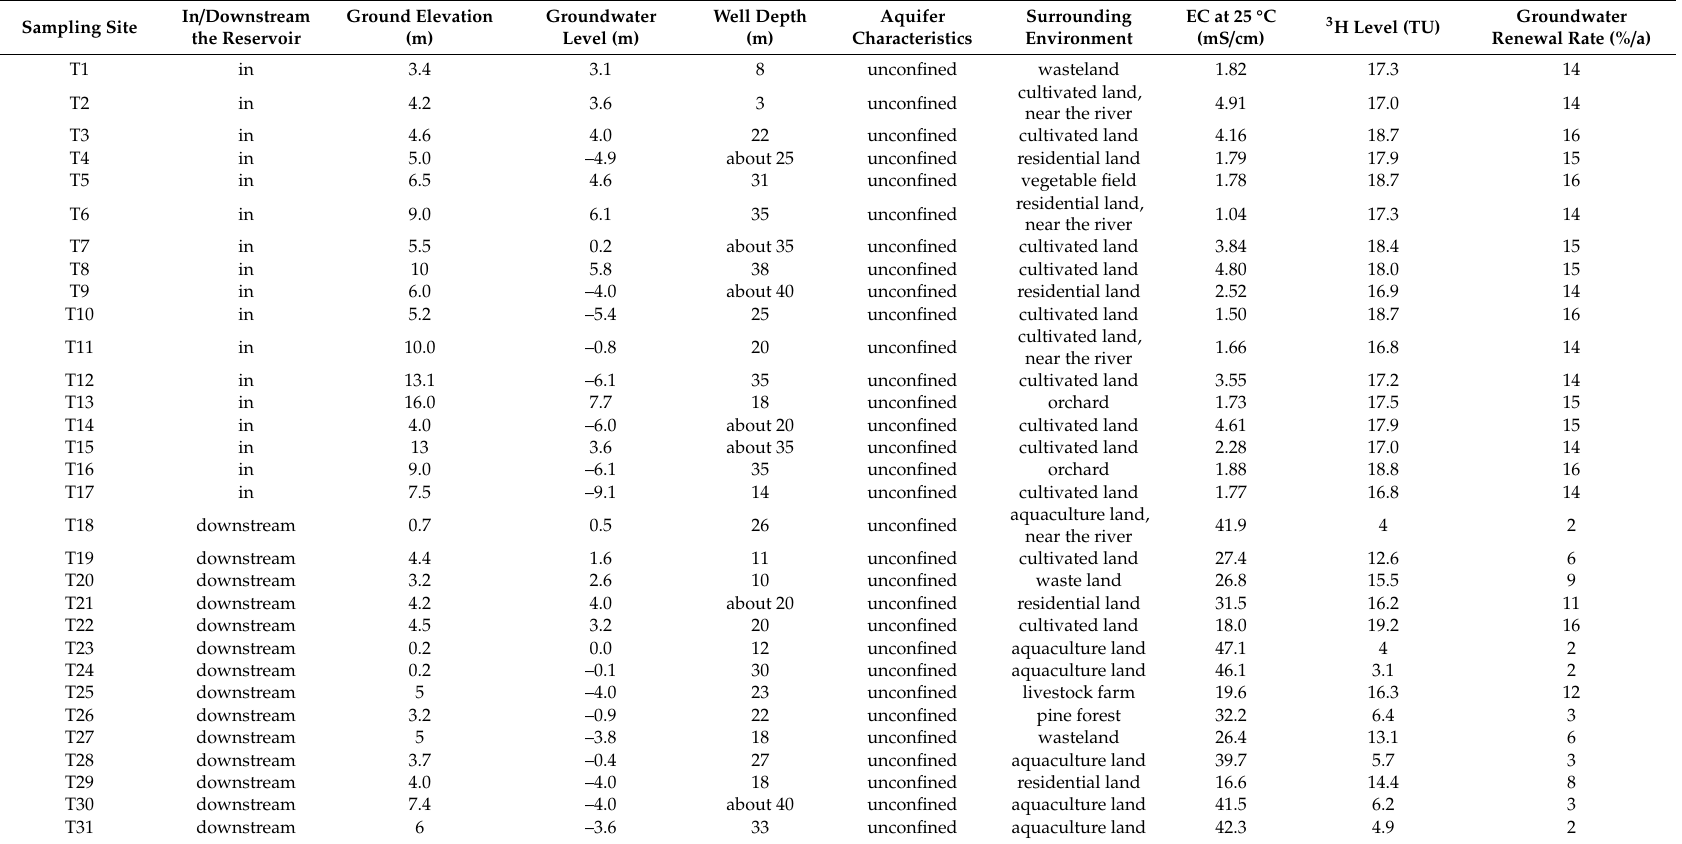
Table 3. Groundwater tritium concentration and renewal